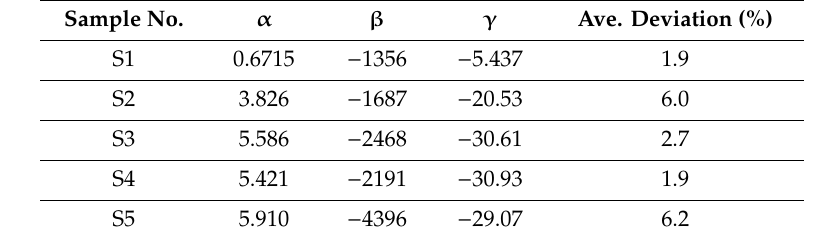
Table 2. Optimum values of Chrastil’s equation and average deviations. Sample No.